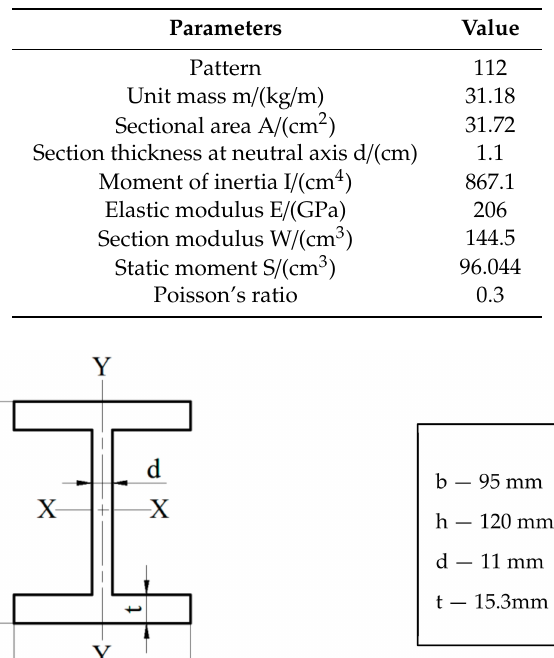
Table 2. Parameters of the 12H mining I-beam.